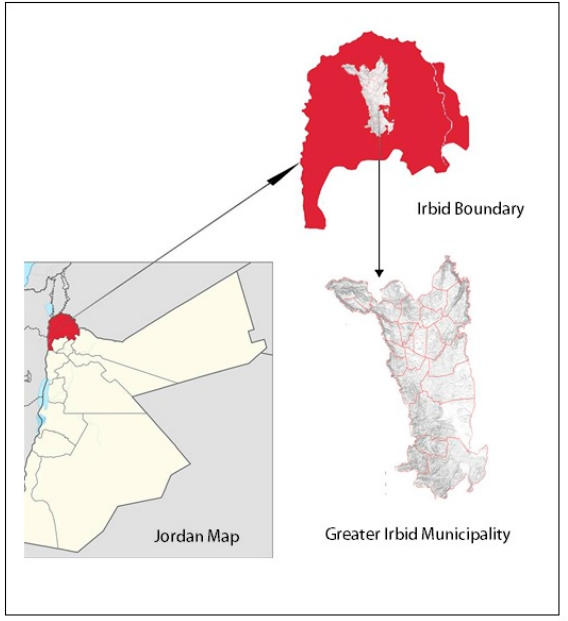
Figure 1. Study area. Map of Greater Irbid Municipality and City of Irbid boundaries (GIM, 2013) [35].